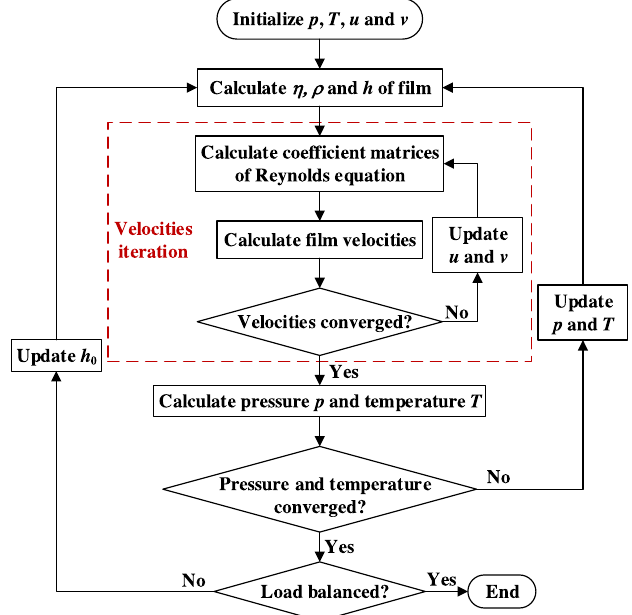
Fig. 2. Flowchart of numerical